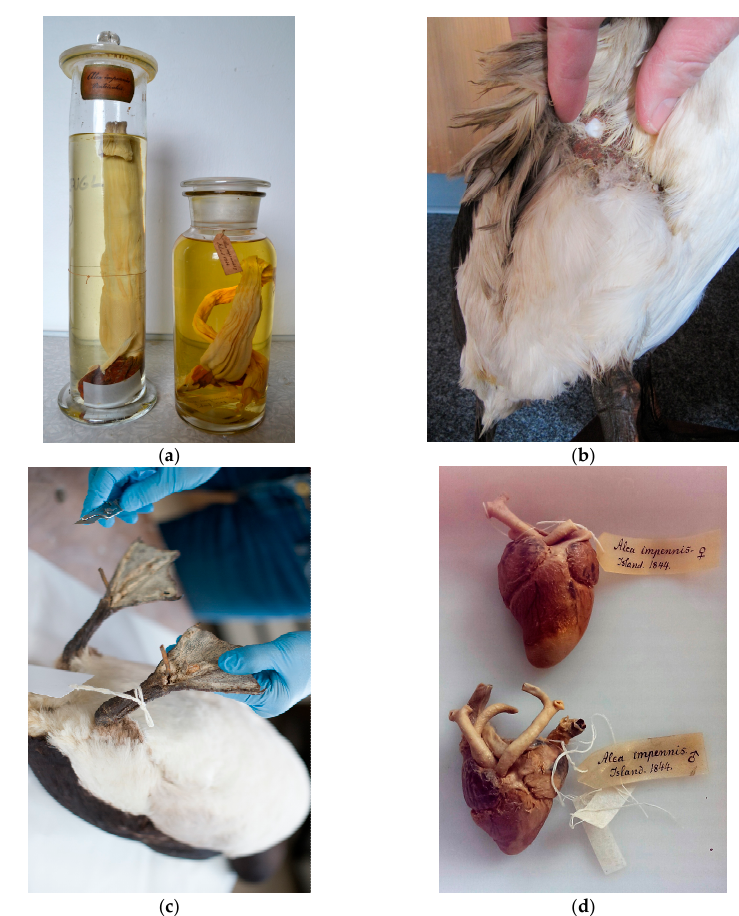
Figure 3. ( a ) Jars containing the oesophagus from the last two individuals killed on Eldey Island. The oesophagus from the larger jar represents that of the individual labelled male (NHMD153069) (MK131). The smaller jar contains the oesophagus from the female bird (NHMD153070) (MK132) (credit. J. Thomas). ( b ) Sampling of The Oldenburg Auk (AVE 8086) (MK133) to remove a section of body tissue for DNA extraction (credit. C. Barilaro, Landesmuseum Natur und Mensch Oldenburg). ( c ) Sampling the toe pad of The Bremen Auk (RKNr. 2392) (MK134) to remove tissue sample (credit